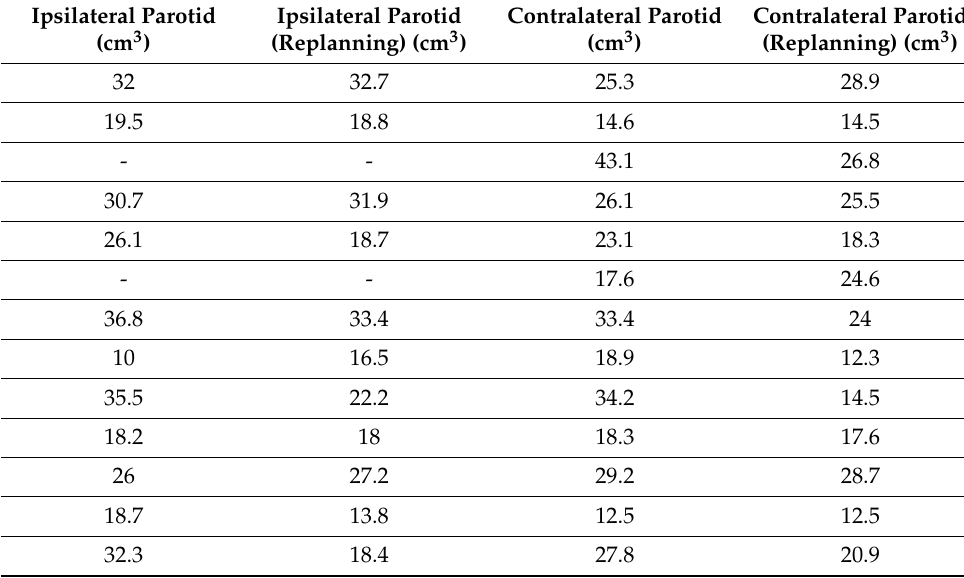
Table 4. Ipsilateral and contralateral parotid size at first and second scan.